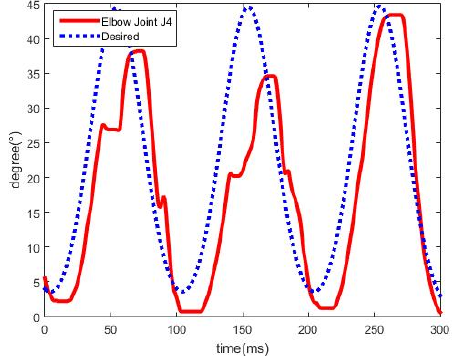
Figure 18. Trajectories of shoulder joint J 2 with instant spasm occurring.